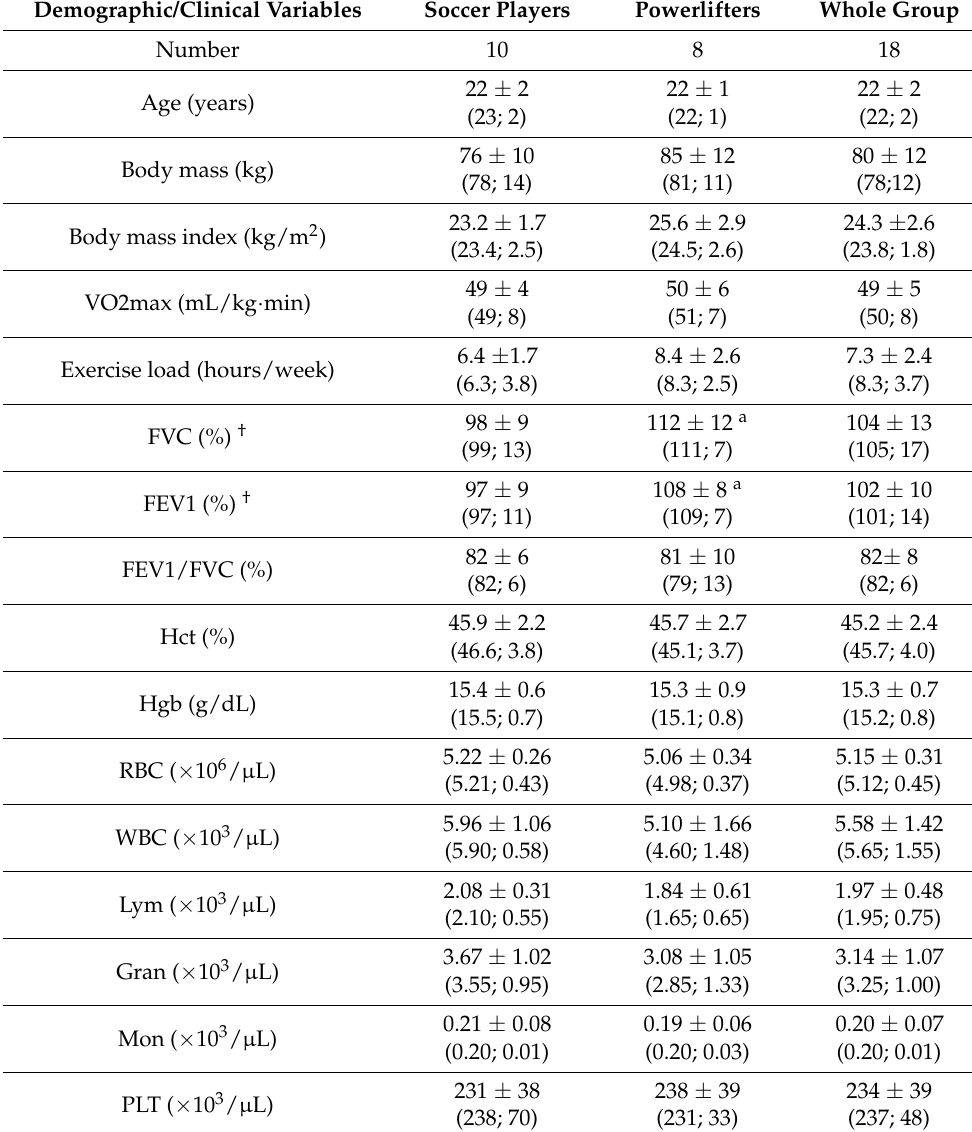
Table 2. Characteristic of studied male